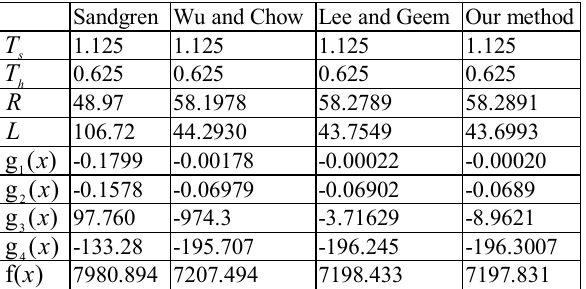
Table 4. Optimization comparisons of pressure vessel design.